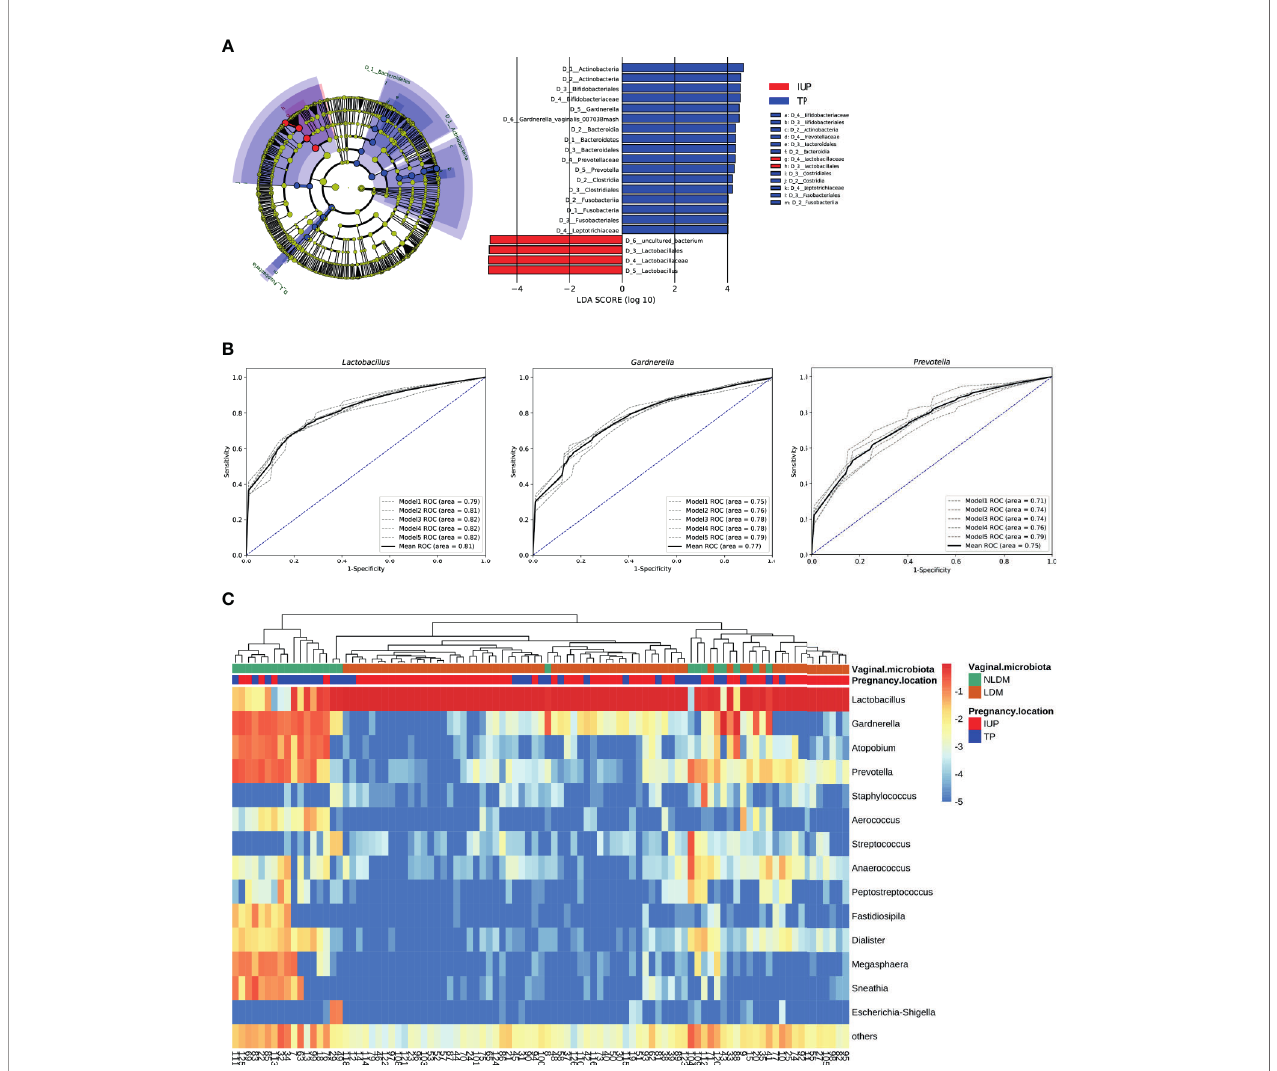
FIGURE 4 | The establishment of Lactobacillus dominated microbiota (LDM) and non- Lactobacillus dominated microbiota (NLDM). (A) Cladogram and scores identi fi ed by linear discriminant analysis (LDA) using LEfSe. The nodes of cladogram from the inner to the outer circles indicated the abundant taxa from the kingdom (D0) to the species (D6) level. Colors represented the groups in which differentially abundant taxa were enriched (red indicated intrauterine pregnancy, blue indicated tubal pregnancy, yellow indicated non-signi fi cant), and the diameter of each node was proportional to the taxon ’ s abundance. The threshold on the logarithmic LDA score was 4.0. (B) Receiver operating characteristic curves for fi ve trials of cross-validated CART of Lactobacillu , Gardnerella , and Prevotella . Black curve indicated the average ROC of the fi ve trials (grey curves). The diagonal lines mark an area under the receiver operating characteristic curves of 0.5. (C) Heatmap of log10- transformed proportions of vaginal microbial taxa composition of 95 subjects clustered by pregnancy location and vaginal microbiota. The lower bar showed the pregnancy location of each subject (red indicated intrauterine pregnancy, blue indicated tubal pregnancy), while the upper bar showed vaginal microbiota (green indicated non- Lactobacillus dominated microbiota, orange indicated Lactobacillus dominated microbiota). The histogram showed the taxon log 10% relative abundance (darkest red indicated greatest abundance; light red and yellow indicated relatively less abundance; and green indicated low abundance or not present). Fourteen of the most abundant genera were